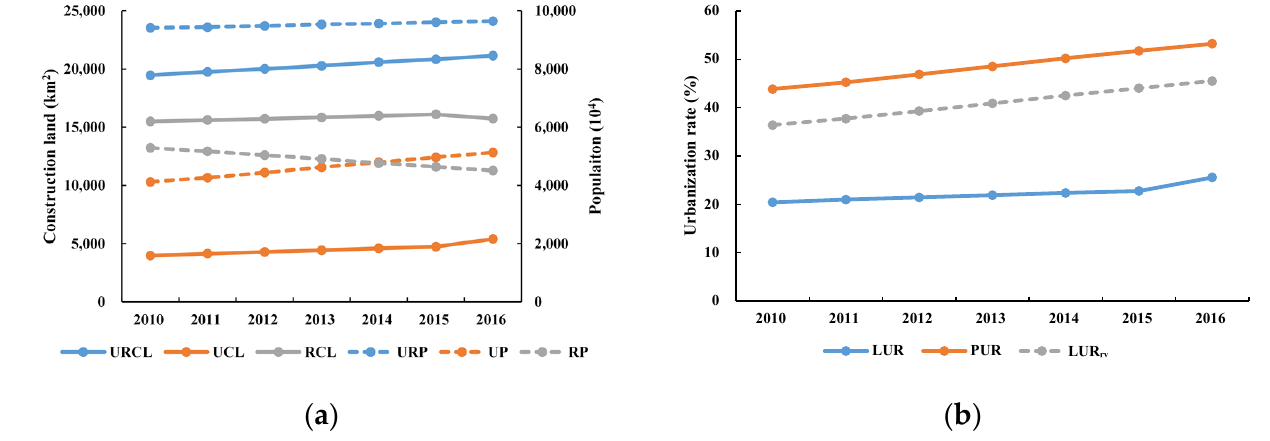
Figure 4. Quantity and structure changes of URCL and population in Henan province from 2010 to 2016: ( a ) changes in URCL, UCL, RCL, URP, UP, and RP; ( b ) changes in LUR, PUR, and the ideal value of LUR (LUR rv ).